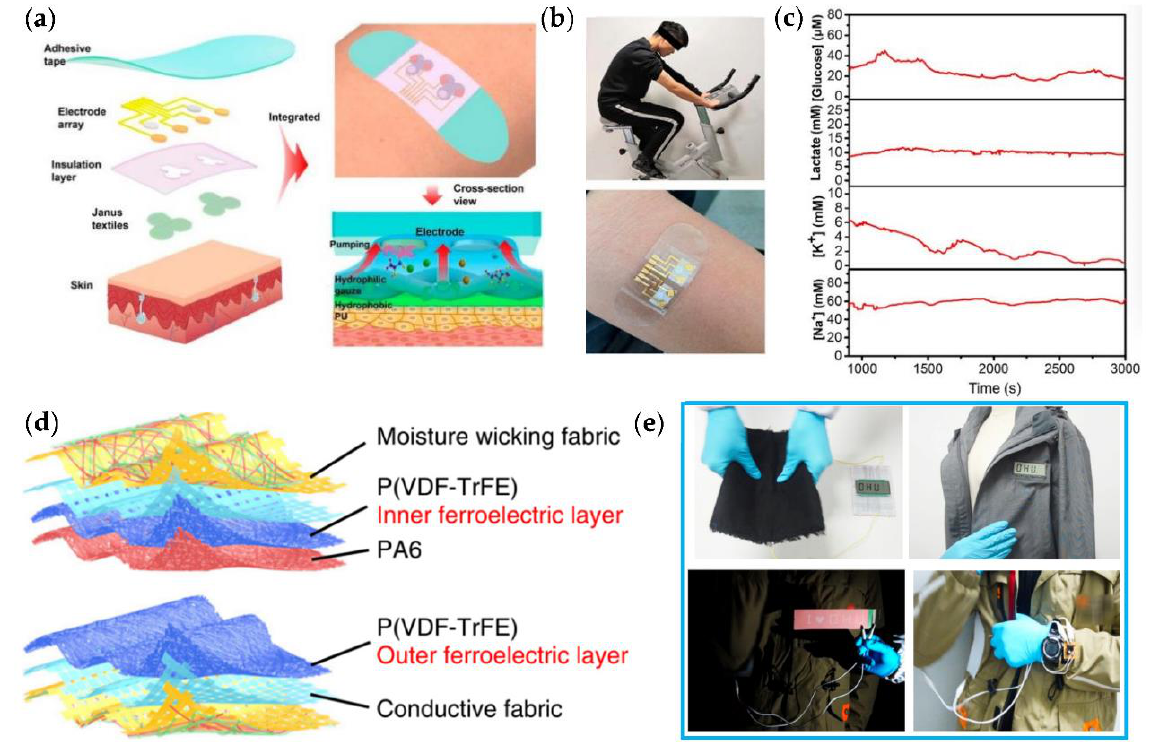
Figure 9. ( a ) Schematic illustration of the sweat sensor with the Janus textile. ( b ) Sweat sensor is worn on a volunteer’s arm during biking activity. ( c ) Signal acquisition for each sensor occurred upon adequate sweat sample collection [70] (Copyright 2020, American Chemical Society). ( d ) Structural diagram of an all-fiber contact-separation mode tribo-ferroelectric synergistic e-textile. ( e ) Various applications of the e-textile: sewn together with common fabrics, sewn into clothes to power the LCD by shaking the clothes, digital electroluminescent lattices, and digital electronic watch [71] (Copyright 2019, Springer Nature).